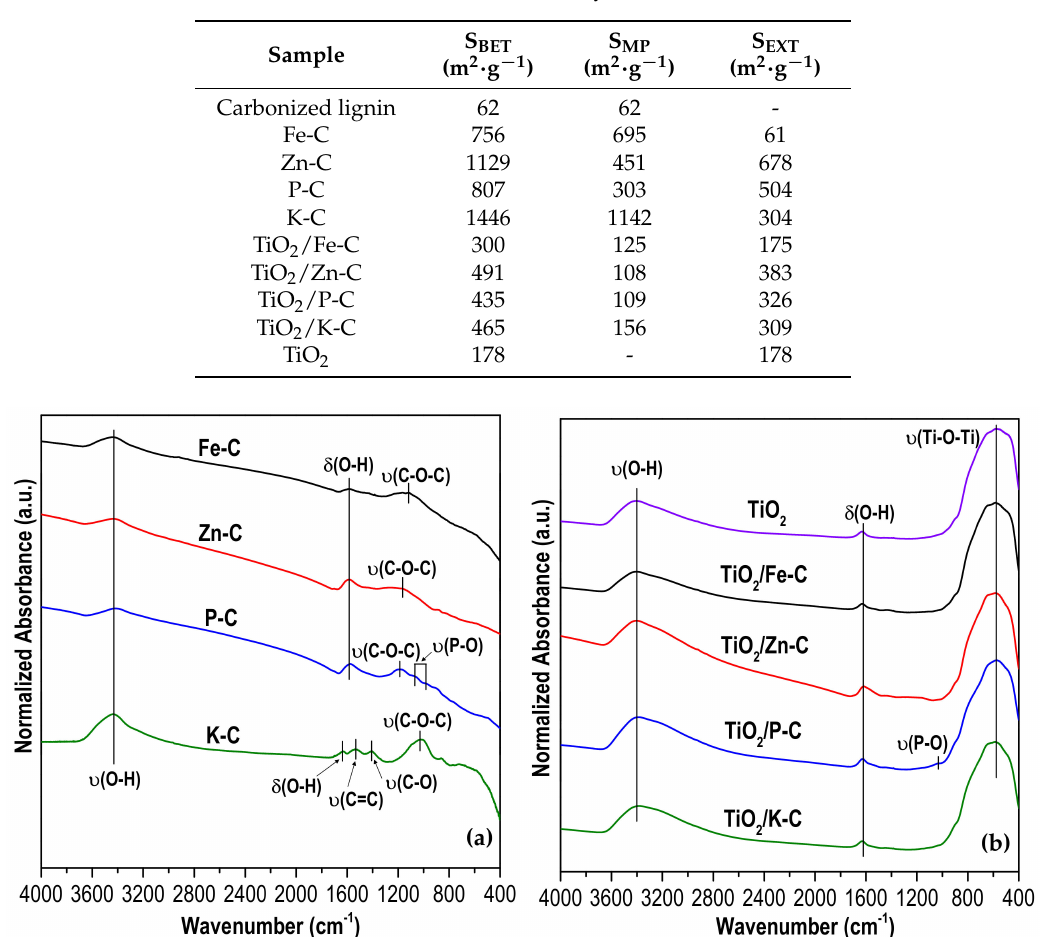
Table 3. Surface area values of the synthesized materials.